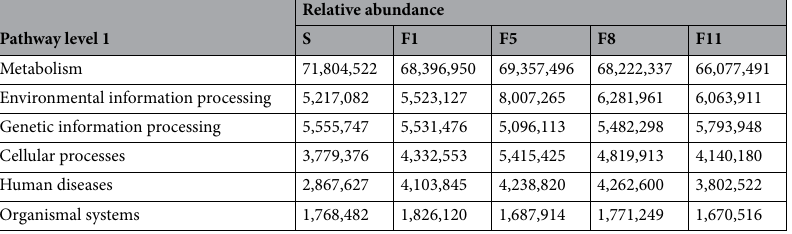
Table 1. Abundance of metabolic pathways in KEGG level 1.